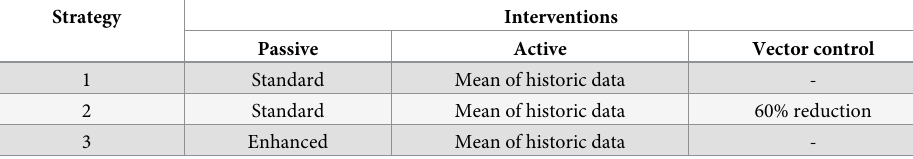
Table 2. Different types of future strategies considered in model